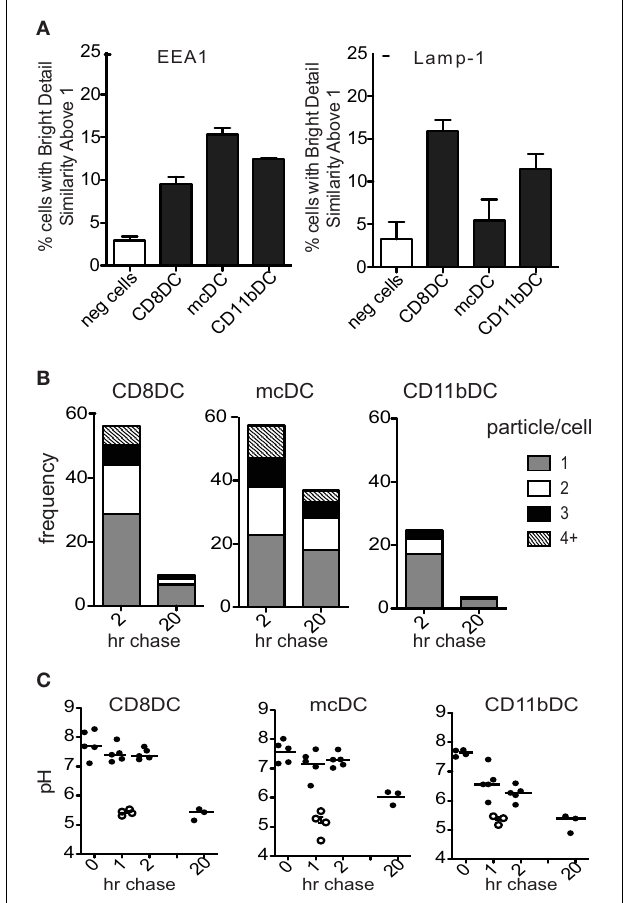
FIGURE 3 | Unique trafficking of phagocytosed material in cross-presenting DCs. (A) ImageStream analysis of the colocalization between internalizedViolet labeled-irradiated cells and PE-labeled EEA-1 or LAMP-1 at 4h ( n > 950 events/group). Colocalization was based upon Bright Detail Similarity score between the two markers. Scores of 0–1 represent minimal colocalization. As the markers of interest become more colocalized the score increases to reflect this similarity. (B) ImageStream analysis of the frequency of CFSE-containing DCs and the number of CFSE + particles per DC 2h and 20h after the removal of irradiated CFSE-labeled cells. Decreases in particle frequency and number/cell were attributed to acidification of the endosome and the subsequent CFSE-quenching. (C) Differences in lysosomal acidification rate between DC populations as determined by flow cytometric analysis of dual-labeled pH-indicating